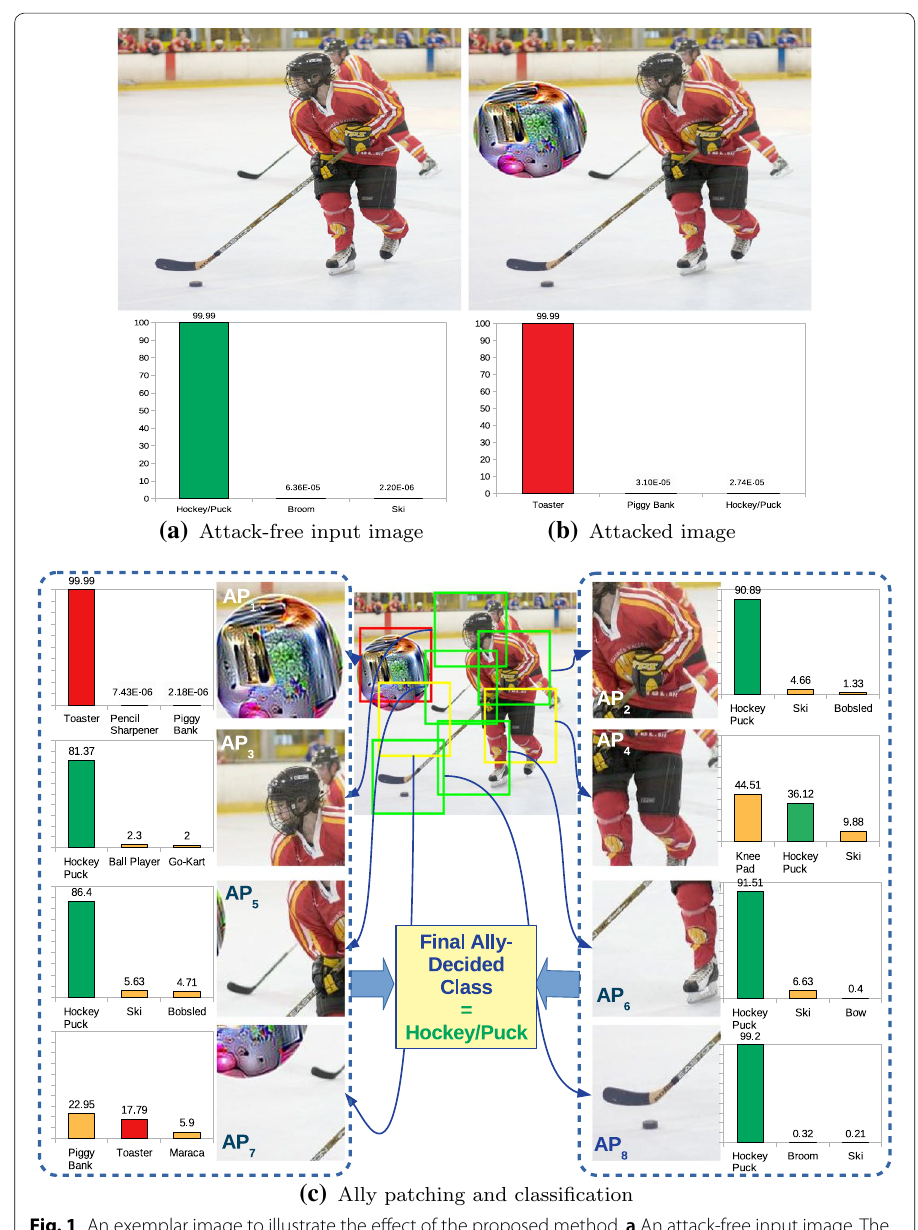
Fig. 1 An exemplar image to illustrate the effect of the proposed method. a An attack‑free input image. The convolutional neural network succeeded in classifying the image in compliance to the ground truth with confidence close to 100%. b The input image after having been attacked by a toaster‑targeted adversarial patch generated by [3]. The adversarial patch succeeded in driving the network to hallucination and to classify the input image to the adversarial target with a confidence value of almost 100%. c Classification using the proposed ally patches. The generated patch alliance could ravage the operation of the adversarial patch and flee from the fake saliency caused by it. For illustration clarity purposes, the confidence values of the top‑3 labels only are shown. The used CNN model for this example is VGG19